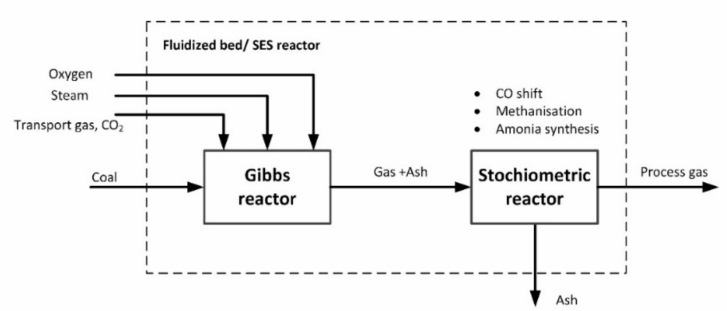
Figure 3. Model of the synthesis energy systems (SES) gasification reactor-calculation scheme [32]. CO shift